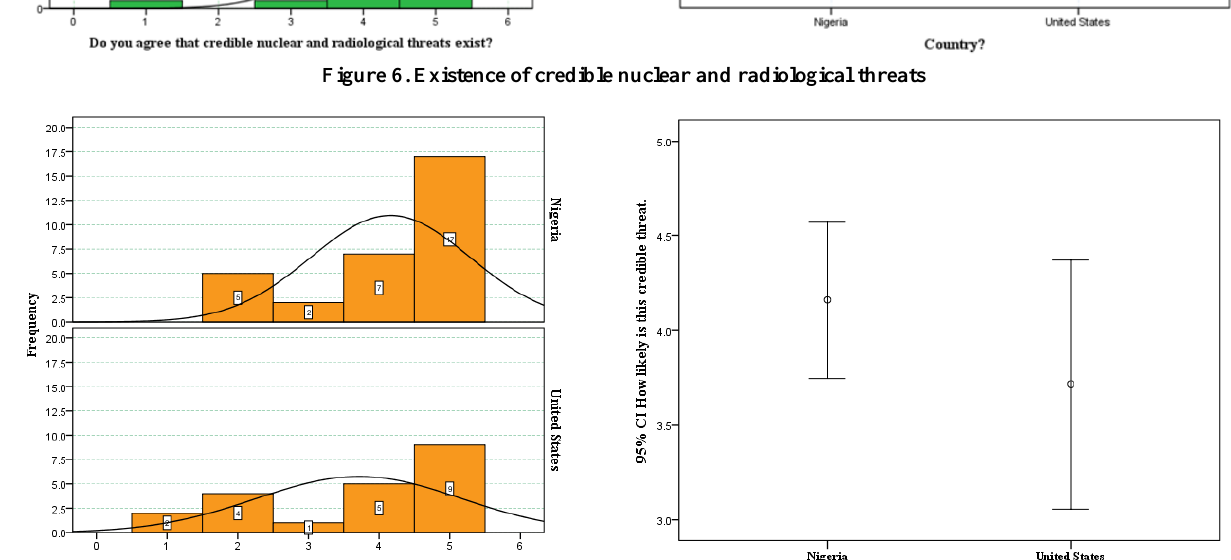
Figure 7. Likelihood of a credible